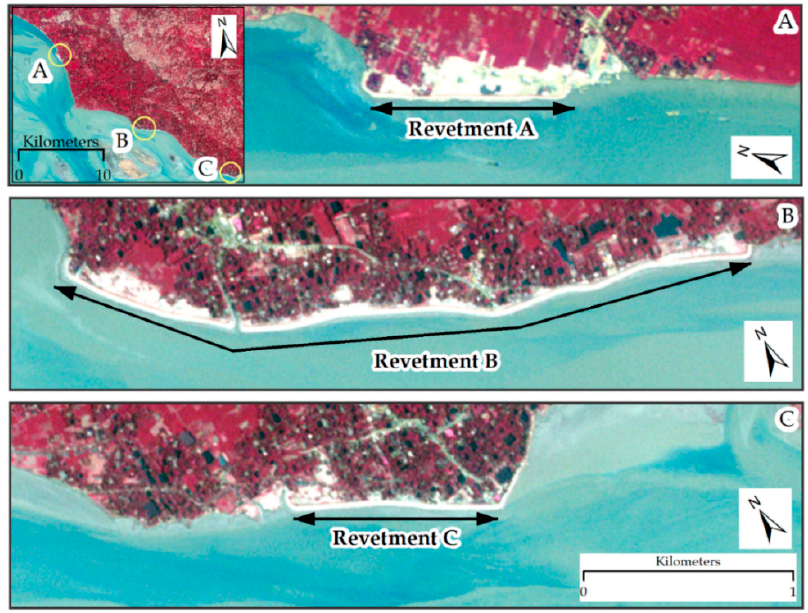
Figure 2. New revetments constructed in Lakshmipur district: ( a ) Revetment A in Kamalnagar Upazila, ( b ) Revetment B in Ramgati Upazila, ( c ) Revetment C in Ramgati Upazila.